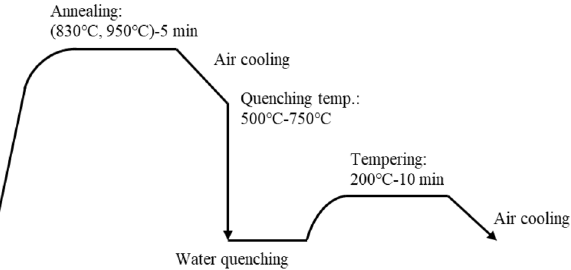
Figure 6. The sequence of heat treatments applied to cold-rolled Fe-C-Si-Mn steel sheets of 1.4 mm in thickness for obtaining ferrite-martensite dual-phase (DP) steel